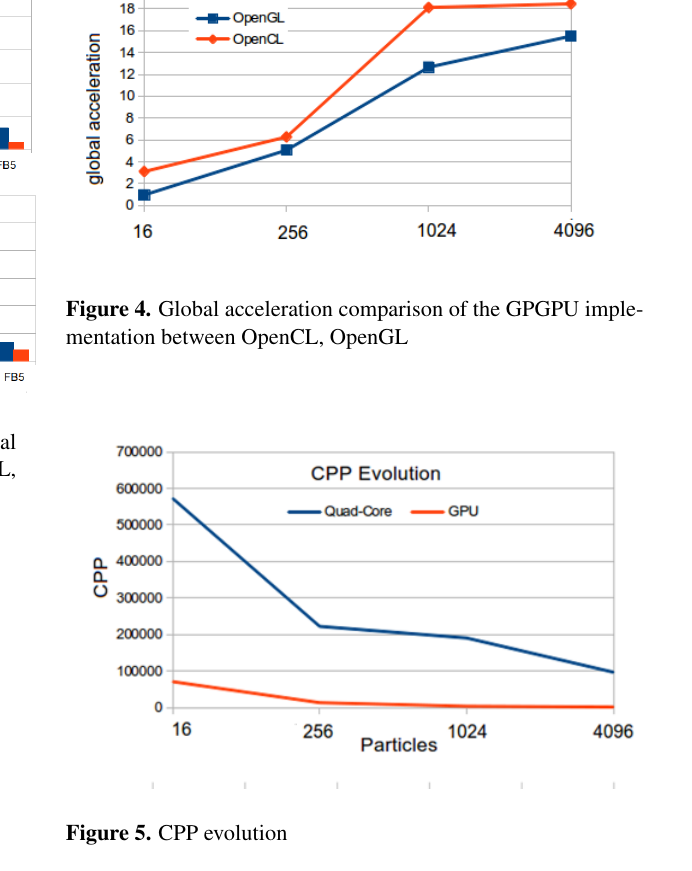
Figure 3. Global processing time comparison of the GPGPU implementation between OpenCL, OpenGL